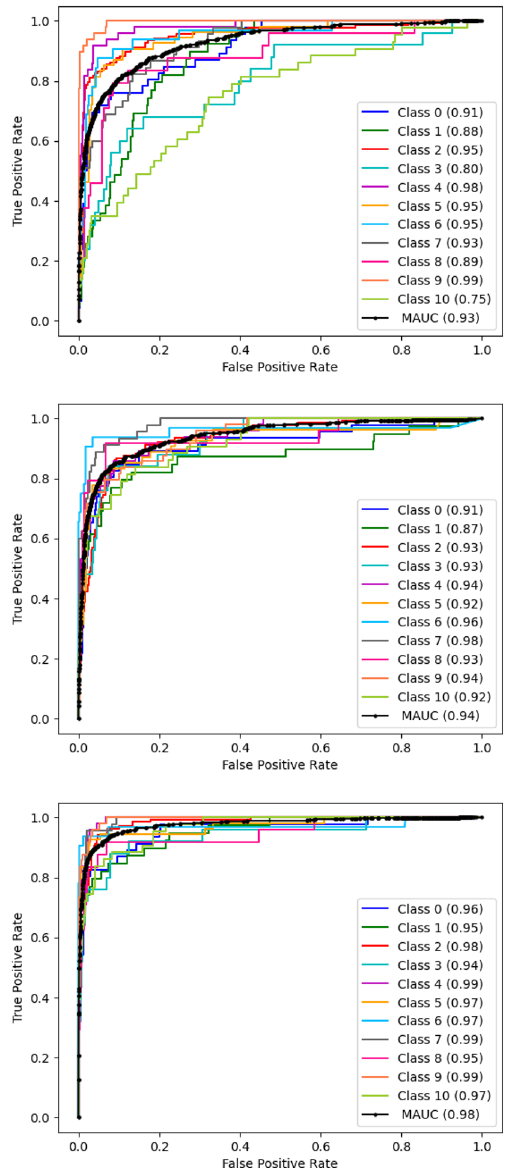
Figure 3. We report the ROC curves and the micro-average scores for the best performing models using different genetic information: ( a ) Using the presence of mutation in a gene as a feature for top 15,000 genes, ( b ) using CNV information in a gene as a feature for top 17,000 genes, ( c ) using both encoded SNV and CNV features with top 34,000